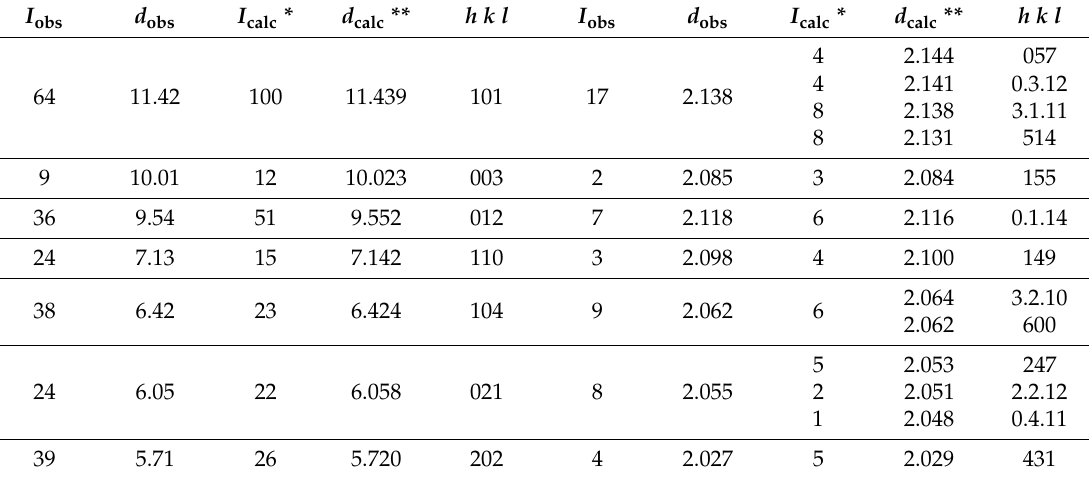
Table 3. Powder X-ray di ff raction data ( d in Å) of